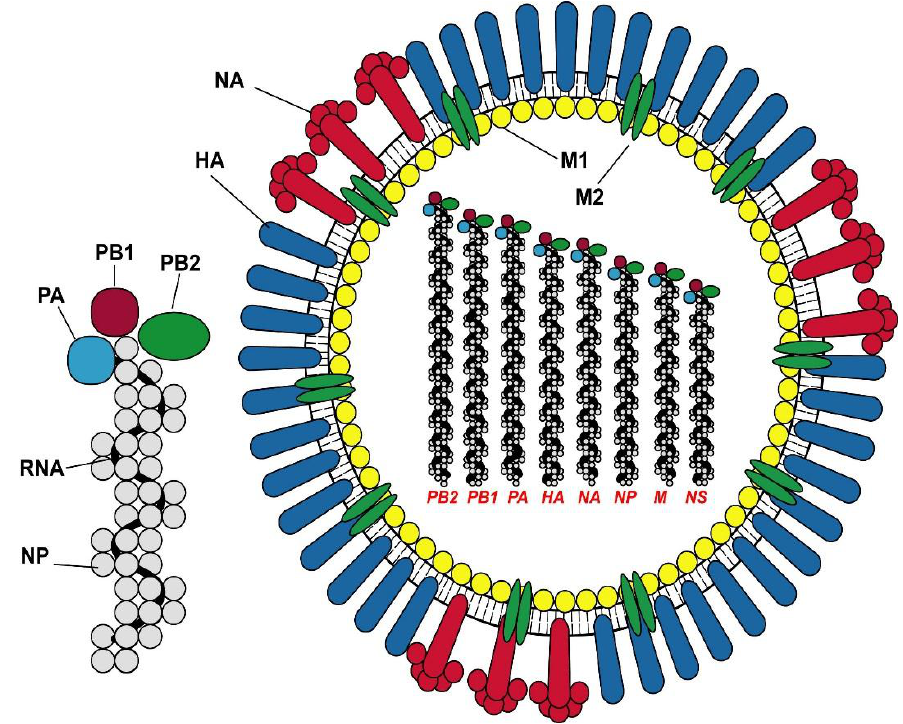
Figure 1. The structure of Influenza A virus and the ribonucleoprotein complex. The virus proteins are denoted as HA hemagglutinin; NA neuraminidase, M1 matrix protein 1; M2 matrix protein 2; NP nucleoprotein; and the polymerase proteins PA, PB1 and